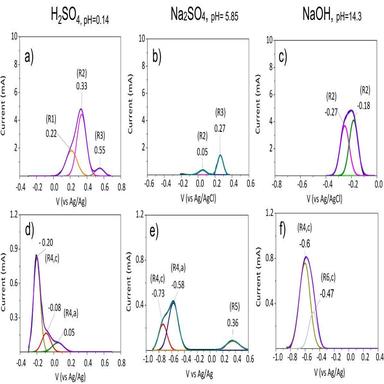
SWV curve deconvolution for pure a–c) CNT and d–f) CeO2 materials in a, d) 1 M H2SO4, b, e) 1 M Na2SO4 and c, f) 1 M NaOH.